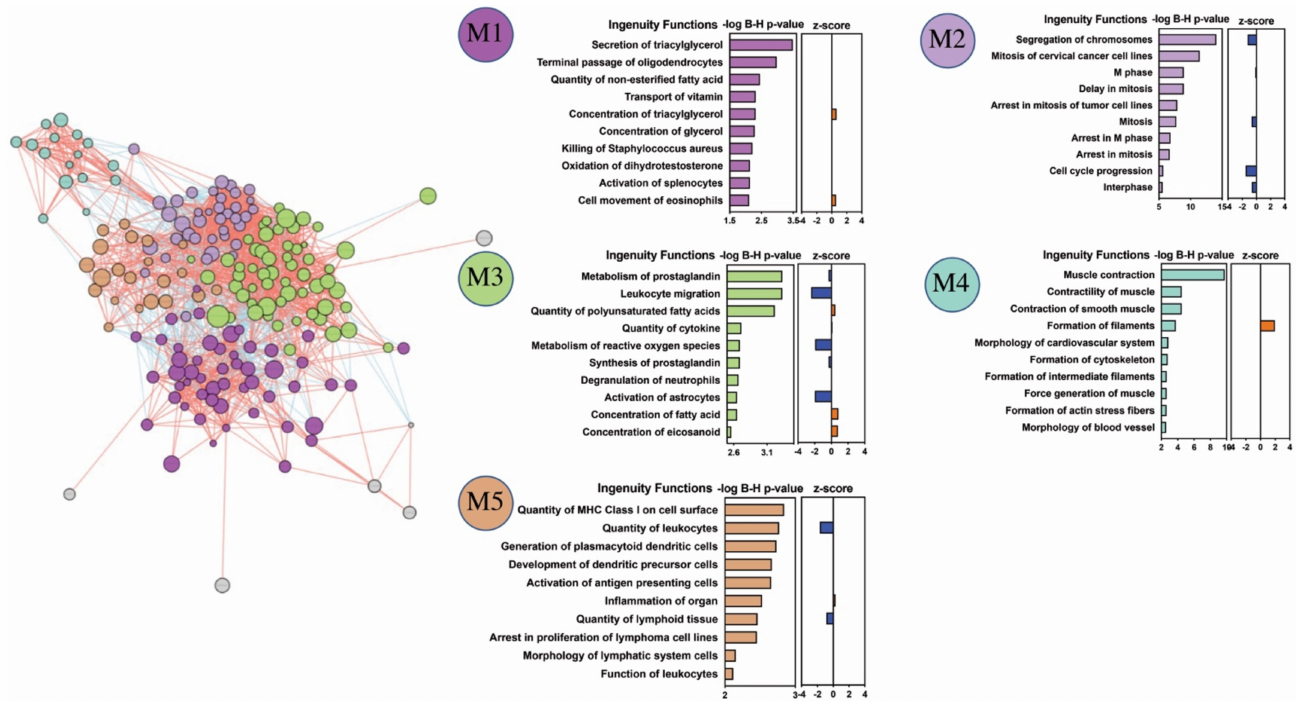
Figure 5. Prediction of the disease relevant pathways represented by differentially expressed genes (DEGs) in nasal biopsy of patients with asthma that is not associated to damp and moldy buildings ( AND ). Five co-expressed gene networks (modules; M1, M2, M3, M4, and M5) were identified from genes that are differentially expressed between AND patients and controls. The interactions between different inferred co-expressed gene network modules, as well as their corresponding biological processes and predicted downstream activation states are shown. Biological functions are ranked by − log of Benjamini–Hochberg corrected p values (implemented filter: exclude cancer pathways; include only pathways with ≥ 5 differentially expressed genes). Positive (+) or negative (-) activation scores correspond to downstream activated or inhibited disease/functions, respectively. An activation Z score > |2| is highly predictive of an activated or inhibited